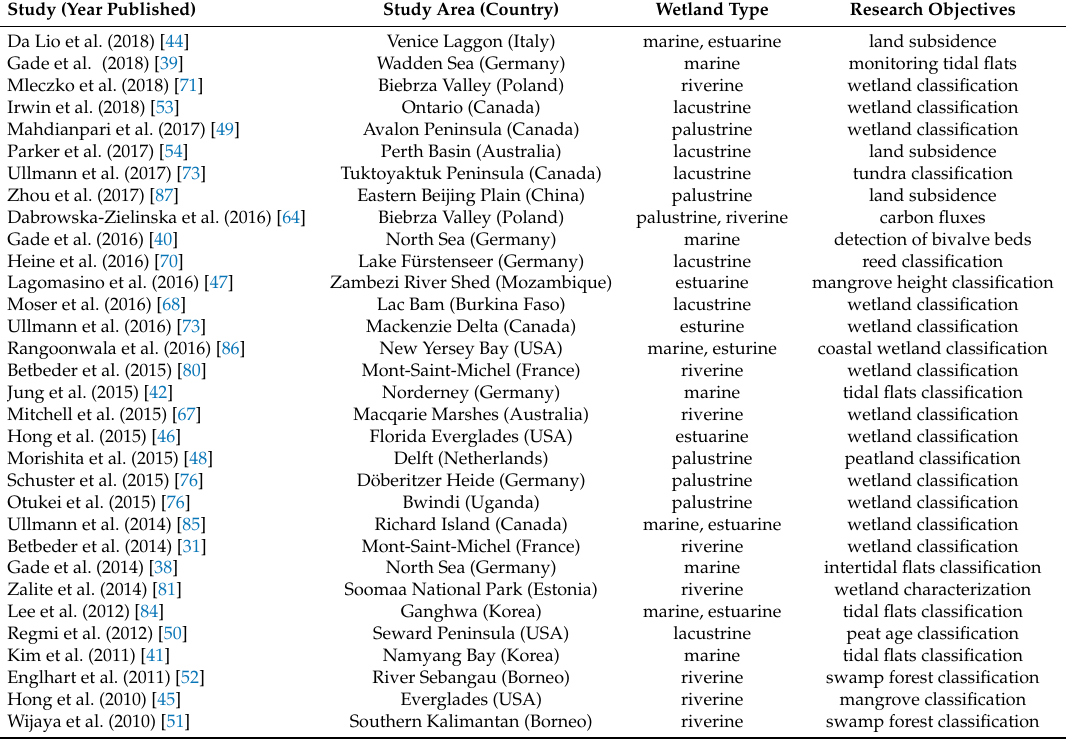
Table A1. Summary of all considered studies in this review using TerraSAR-X data in the domain of wetland research (in chronological